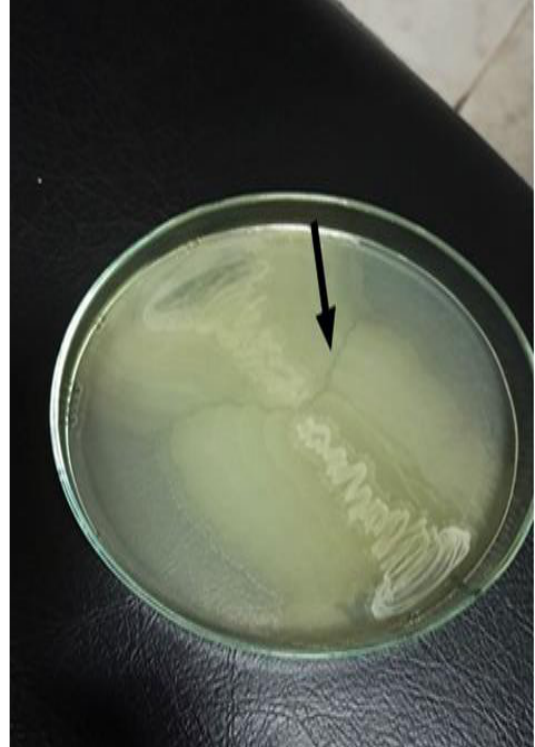
Figure 2. The Dienes test showing distict line between urease negative P. mirabilis and other urease positive P. mirabilis